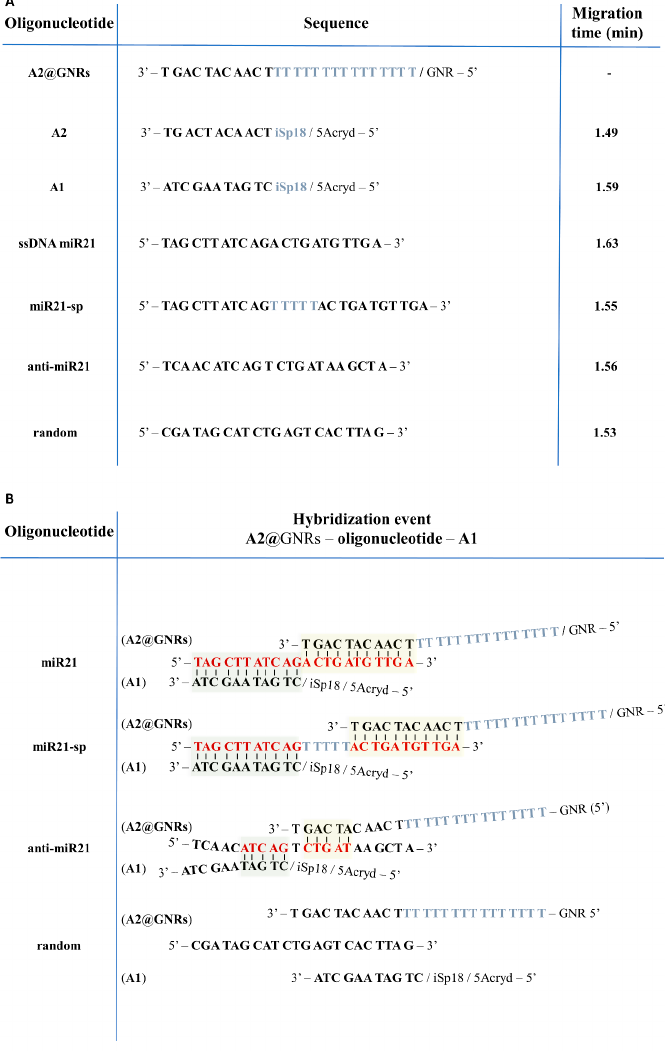
Figure 2. ( A ) The corresponding sequences and relative migration times of oligonucleotides in- volved in the study, calculated as relative to the migration time of the internal standard Orange G (OG), ( B ) Chemical structures and the expected complementarity of the DNA oligonucleotides involved in the study